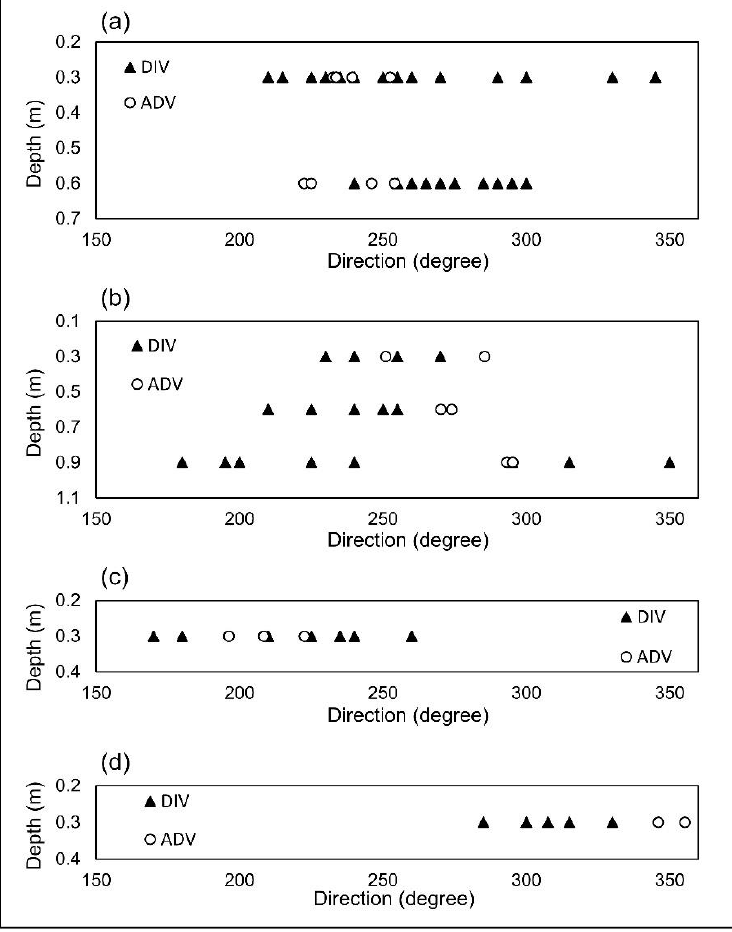
Figure 8. Validation tests results for flow direction at ( a ) P1; ( b ) P2; ( c ) P3; and ( d ) P4.